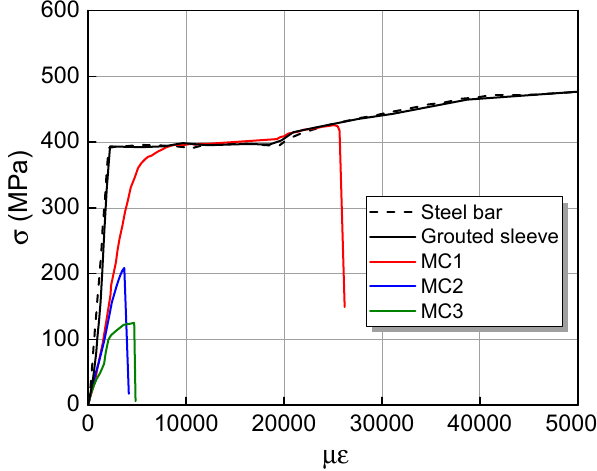
Figure 15. Tensile behavior of different bar splicing methods.